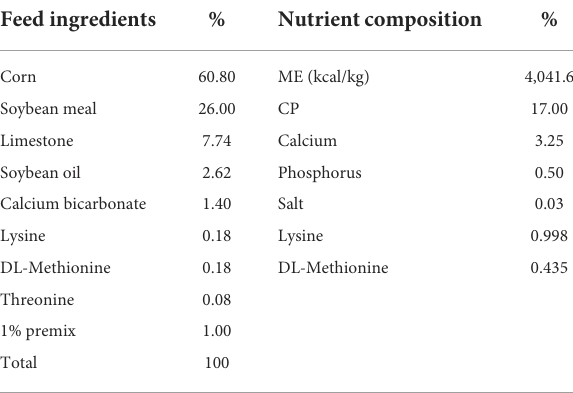
TABLE 1 Ingredients in the basic diets and nutritional composition. Feed